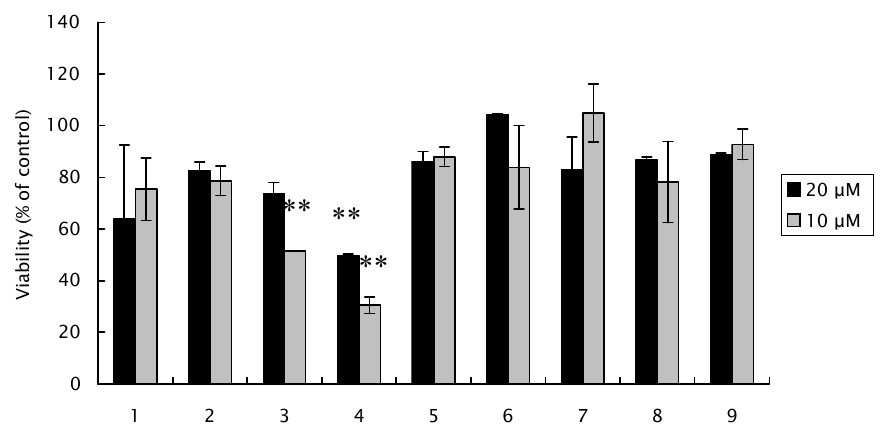
Figure 3. Antiproliferative effects of suffruyabiosides A ( 1 ) and B ( 2 ), and known compounds 3 – 9 for A549 cells. Cells were incubated with different concentration of each compound for 48 h in 96-well plates. Proliferation was measured by WST-8 Assay. Results are expressed as percentage cell proliferation relative to the control group. This assay was repeated two times. Data are the mean ± SD of three determinations. ** significant difference ( p < 0.01) vs . control cells. (Dunnett’s